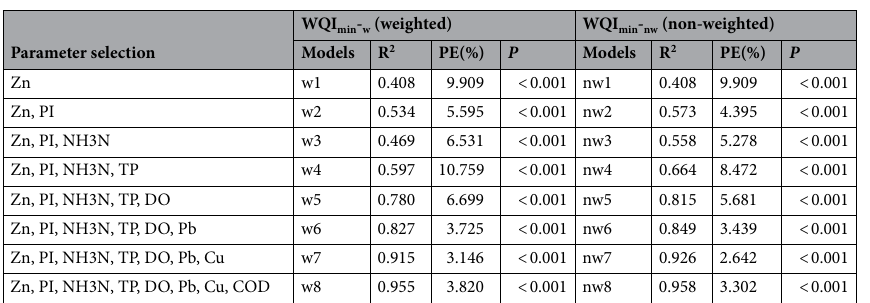
Table 2. The parameter selection results of the WQI min models from the stepwise multiple linear regression based on the training dataset (n = 264).